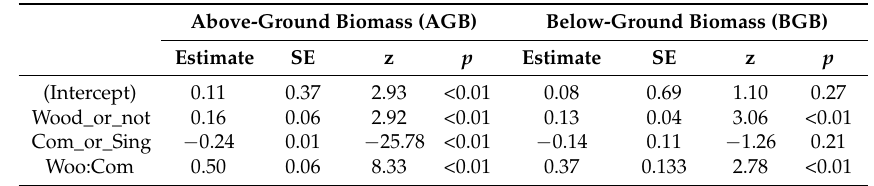
Table 2. Generalized linear regression model was used to test whether plant types (herbaceous versus woody species), the different responses of the plant community and its dominant species, and the combined synergies would affect biomass accumulation patterns. Model-averaged coefficients, standard errors (SE), z-tests, and p -values for parameters are given.